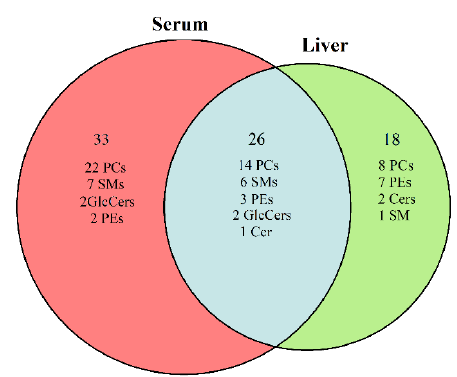
Figure 3. Venn diagram. Each circle represented the potential lipid markers based on the comparisons of the AAI group versus the control group in serum and liver, respectively.